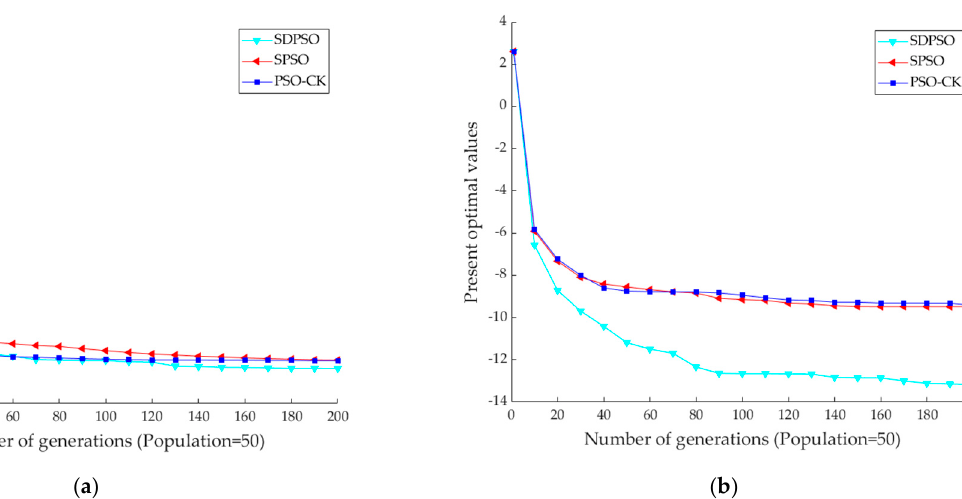
Figure 7. Convergence history of the mean of the present optimal values of the 25 repetitions obtained by PSO-CK, SPSO, and SDPSO, respectively. ( a )BOP1; ( b )BOP2.